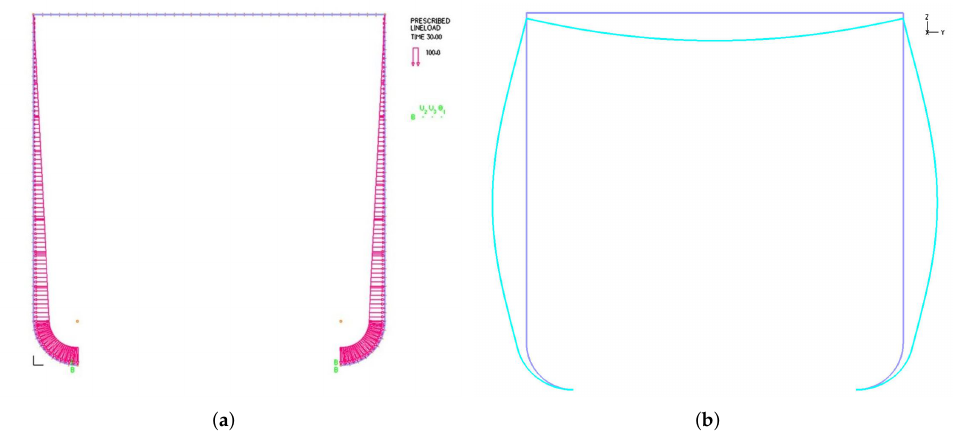
Figure 10. ADINA Simulation of the full-fledged beam-column model with curved design features at the bottom. ( a ) 2D model with curved corner, ( b )